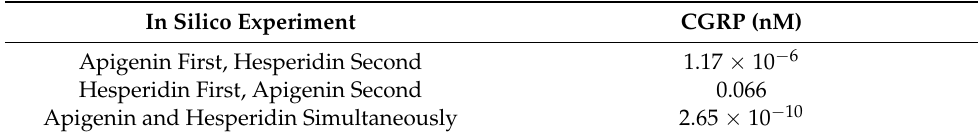
Table 4. Estimations for additive ranges of